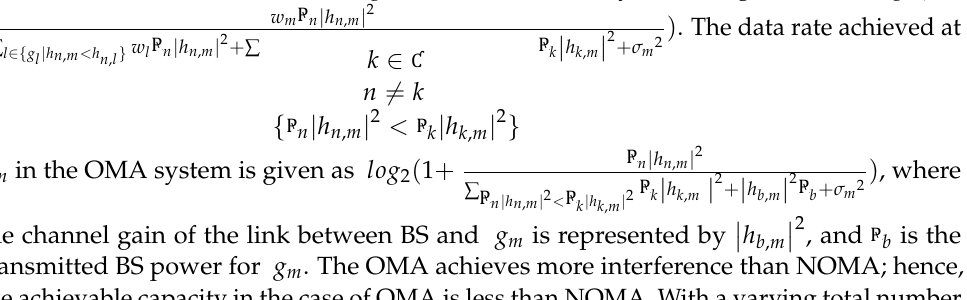
Table 2. Notations. Table 2. Table 2. Notations.